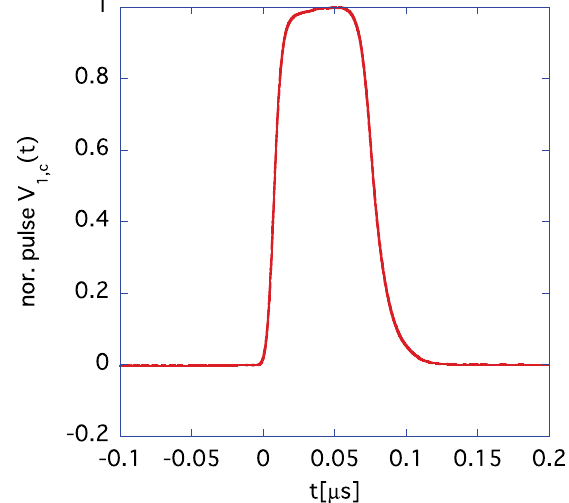
FIG. 20. Reproduced current signal by using the monitored